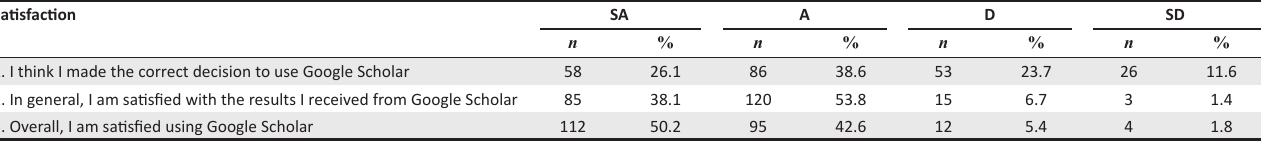
TABLE 6: Satisfaction of postgraduate students with Google Scholar.